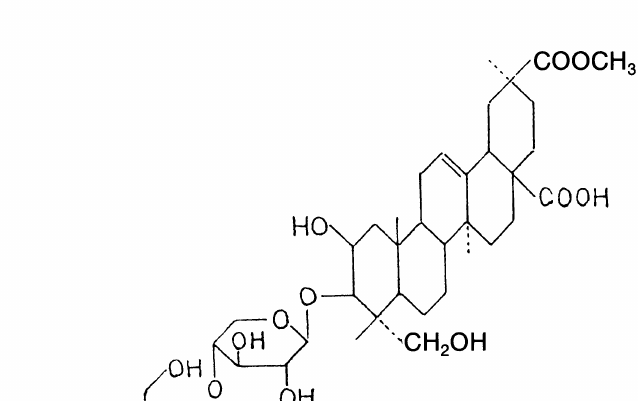
FIG. 1. The structure of esculentoside